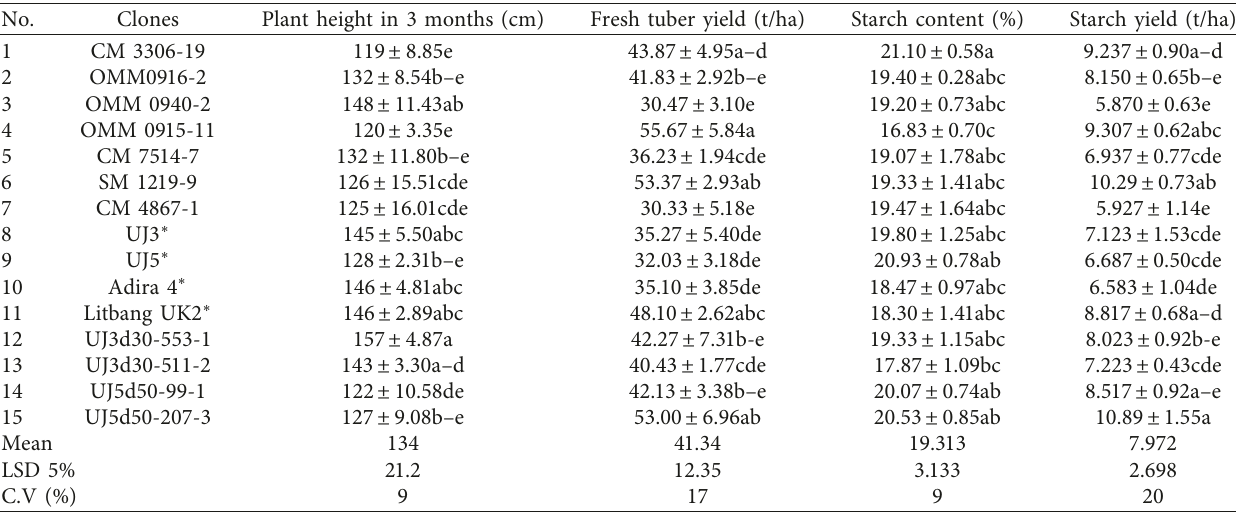
Table 1: Plant height (cm ± SE), fresh tuber yield ( t ± SE), starch content ( ± SE), and starch yield ( t ± SE) of cassava promising clones in Malang, 2018.